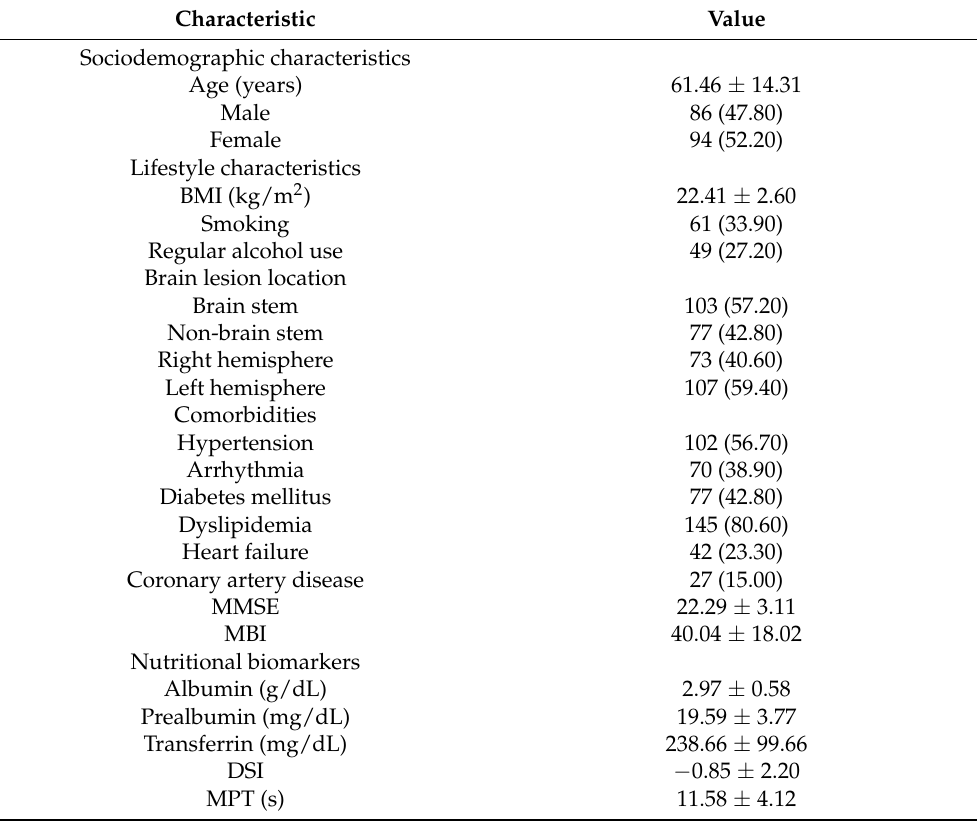
Table 1. Demographic characteristics of the study participants.